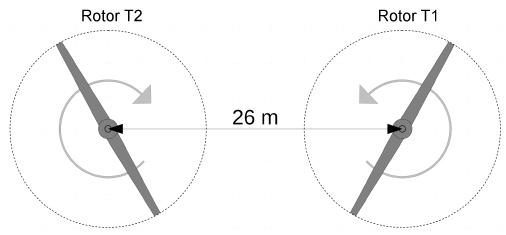
Figure 11. Contra-rotating rotors with centres separated by 26 m.